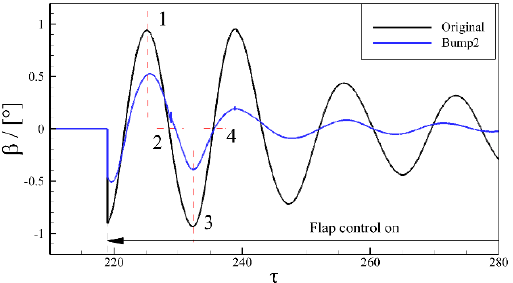
Figure 12. Diagram of time phase in one period when flap control on.